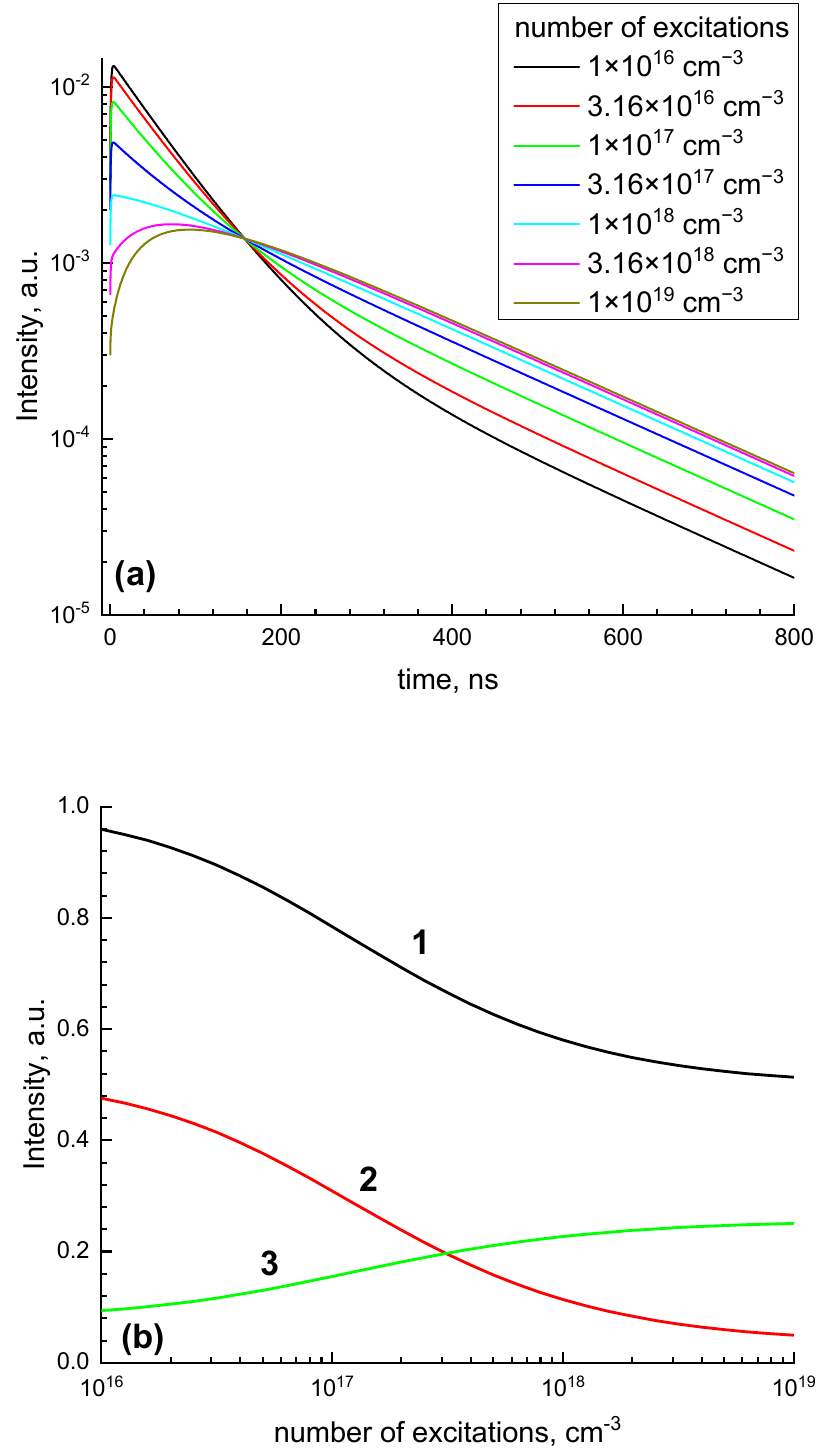
Figure 8. Results of numerical simulation using Equation (2) of the dependencies of decay kinetics ( a ) and emission intensity ( b ), total (1) and time-resolved in time windows 0–50 ns (2) and 200–5000 ns (3) on the initial concentrations of excitations.